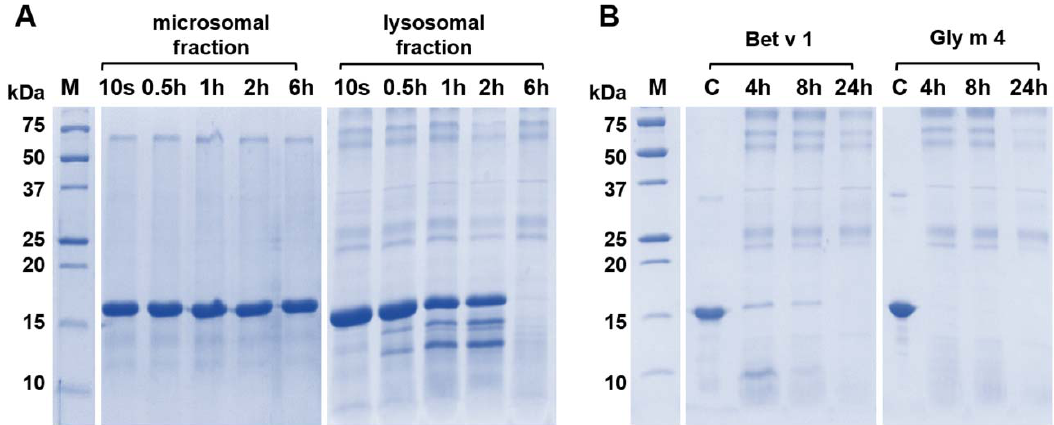
Figure 7. The allergen Gly m 4 degradation in vitro by enzymes of microsomal or lysosomal fractions of human macrophages as detected by SDS-PAGE (15%T, 3%C in separating gel). ( A ) Comparison of rates of the Gly m 4 cleavage in the presence of microsomal or lysosomal fractions for 10 s, 0.5 h, 1 h, 6 h or 24 h. ( B ) Comparison of rates of cleavage of two allergens—the birch Bet v 1 and the soybean Gly m 4 in the presence of the lysosomal fraction; 4 h, 8 h and 24 h—digestion time. M—molecular mass standards. C—the intact Bet v 1 or Gly m 4 (control).